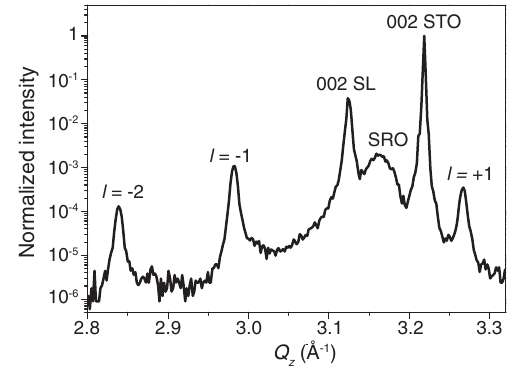
FIG. 9. Diffraction pattern of the PTO/STO SL along the line Q ¼ Q ¼ 0 . x y